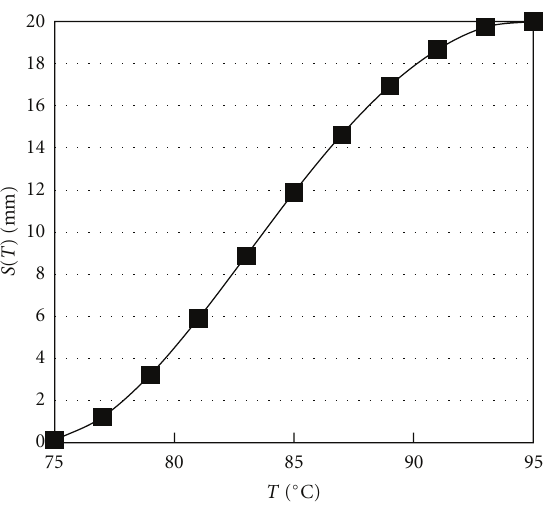
Figure 5: The output displacement versus